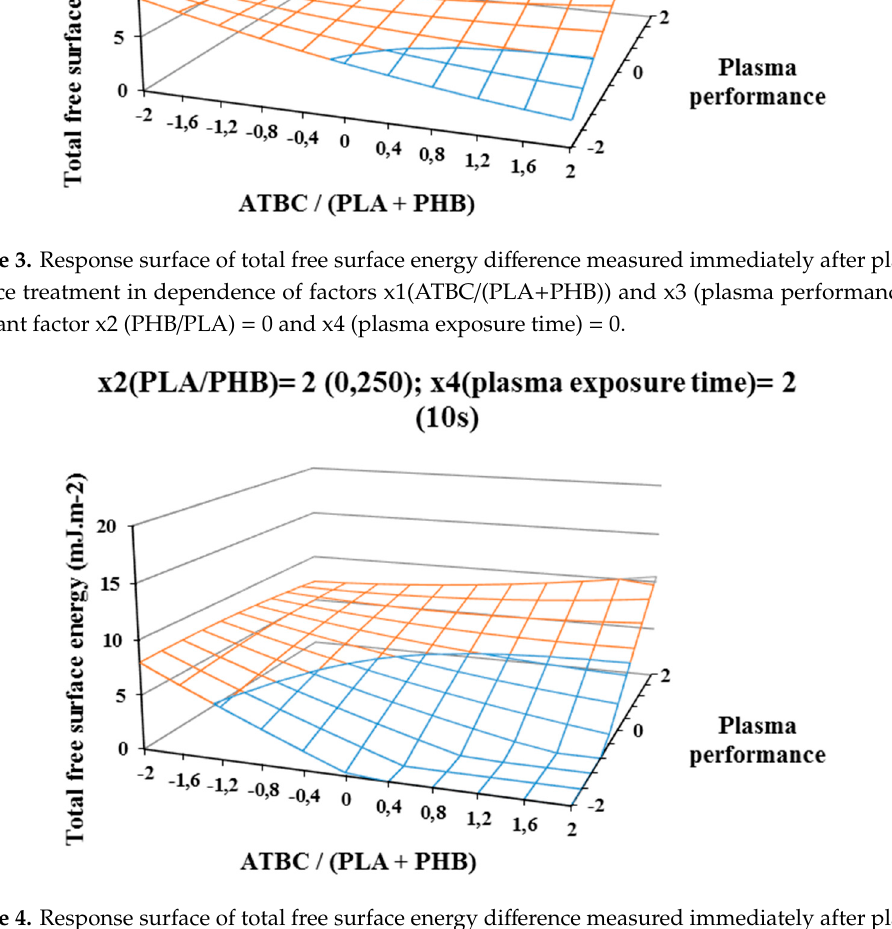
Figure 4. Response surface of total free surface energy difference measured immediately after plasma surface treatment in dependence of factors x1 (ATBC/(PLA + PHB)) and x3 (plasma power) at constant factor x2 (PHB/PLA) = 2 and x4 (plasma exposure time) = 2 .